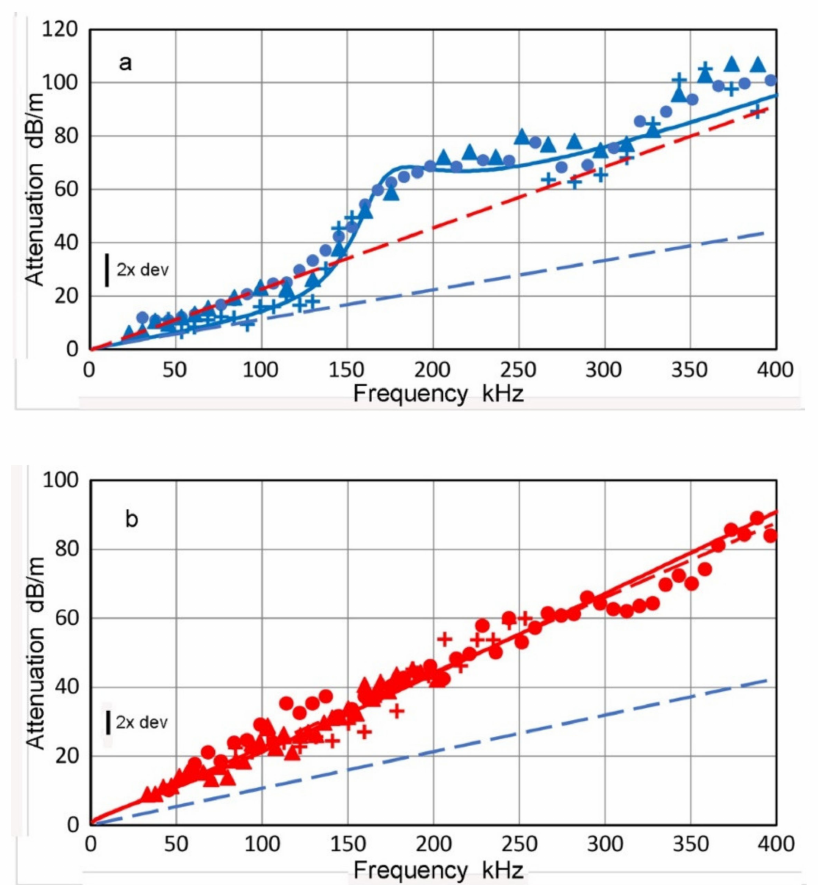
Figure 15. ( a ) Observed α –S o values for 6.3-mm PMMA plate along with the calculated attenuation and dashed lines for α L and α T . Three test series are plotted using blue symbols. Dot and triangle data used Olympus V101 Tx and PAC Pico Rx, and + symbols used Olympus V101 Tx and KRN-BB- PC Rx. All with short-pulse excitation. Vertical bar shows 2 × dev. ( b ) Observed α –A o values for 6.3-mm PMMA plate along with the calculated attenuation and dashed lines for α L and α T . Three test series are plotted using red symbols. Dot and triangle data used Olympus V103 Tx and NDT C16 Tx at 60 ◦ incident angle, respectively, with PAC Pico Rx, and + symbols used Olympus V221 Tx and KRN-BB-PC Rx. The poling direction of V221 was oriented to match the plate surface normal. All with short-pulse excitation. Vertical bar shows 2 ×